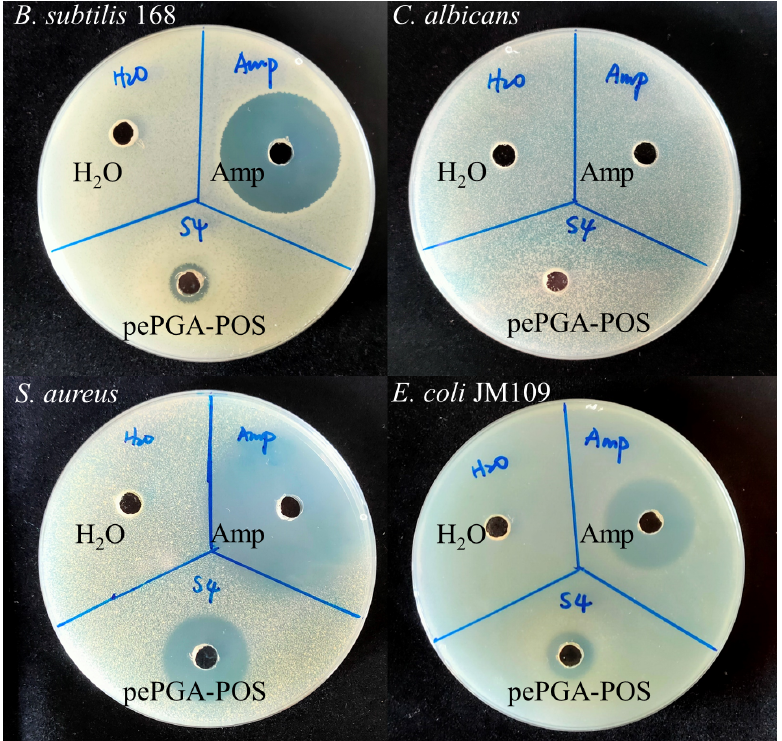
Figure 6. Antibacterial activities of pePGA-POS against B. subtilis 168, C. albicans , S. aureus and E. coli JM109. Table 1. The minimum inhibitory concentration (MIC) of pePGA ‐ POS to inhibit the growth of E. coli JM109, B. subtilis 168 and S. aureus .